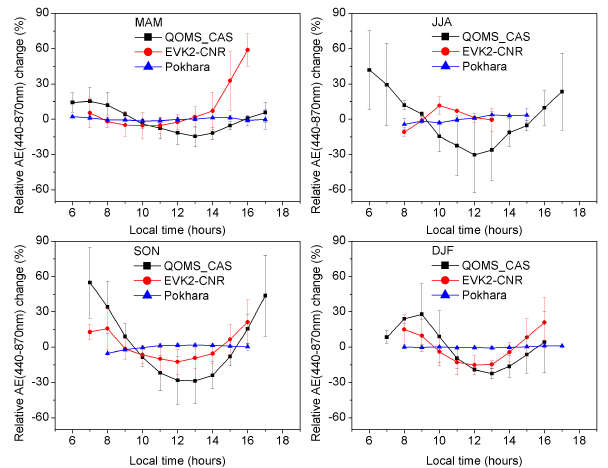
Fig. 10. Percentage deviations of hourly average AE at 440–870nm relative to their daily mean across all seasons at QOMS_CAS, EVK2-CNR and Pokhara. The error bars indicate the inter-annual difference of relative AE at each